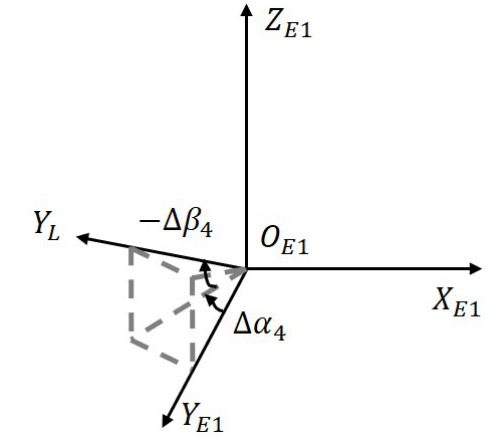
Figure 7. Perpendicularity error of optical